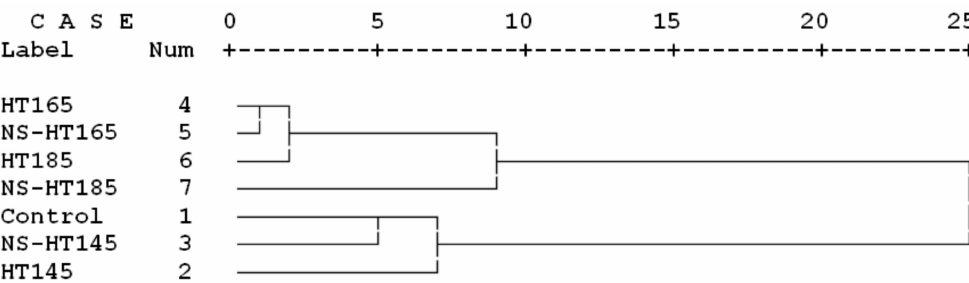
Figure 9. Cluster analysis based on all physical and mechanical properties, as well as crystallinity values of the seven treatments studied in the present project (HT = heat treatment at a determined temperature; NS = nanosilver